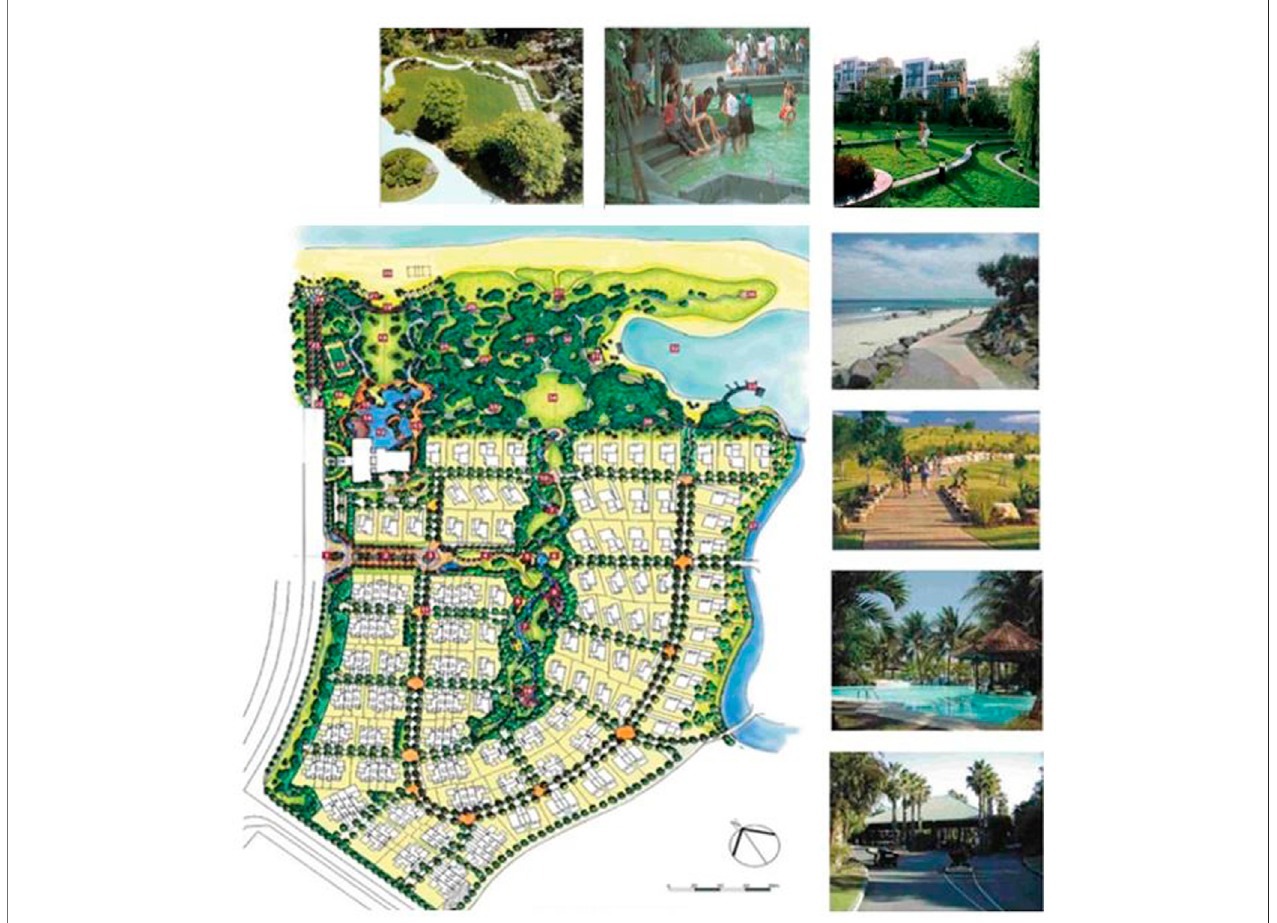
FIGURE 6 | Recommended Green Happy Neighbourhood planned layout; Source: Authors ’ fi eld research, (2022).